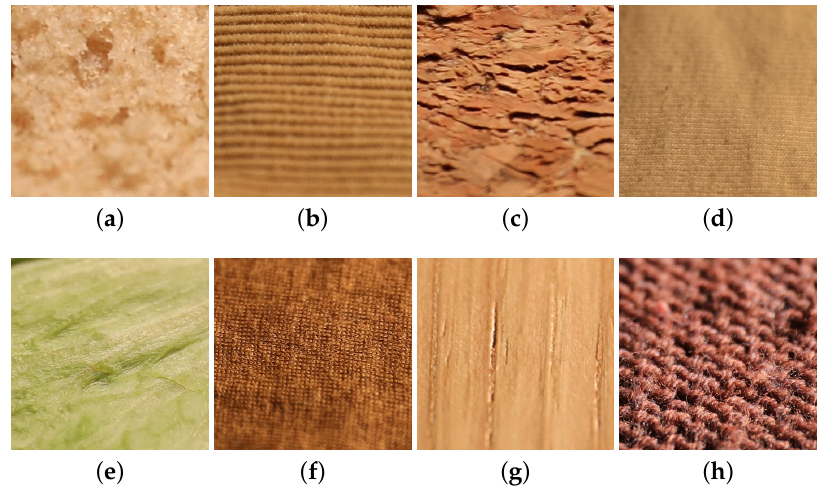
Figure 12. Image samples appeared as out of focus for the categories ( a ) brown bread, ( b ) corduroy, ( c ) cork, ( d ) cotton, ( e ) lettuce leaf, ( f ) linen, ( g ) wood, and ( h ) wool from the UJM-TIV